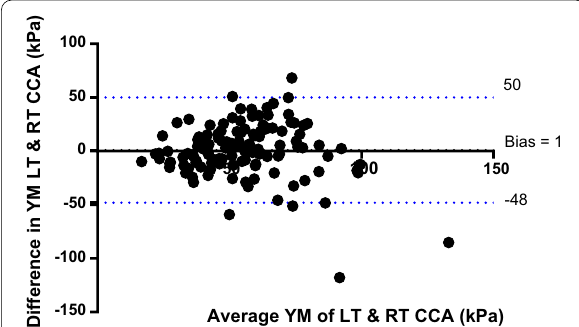
Fig. 1 Bland–Altman plot comparing mean YM measurements between two adjacent ROIs in 127 participants. The 95% limits of agreement remain wide (~ 20 kPa) even in adjacent ROIs suggesting that SWE YM estimates have high intrinsic variability